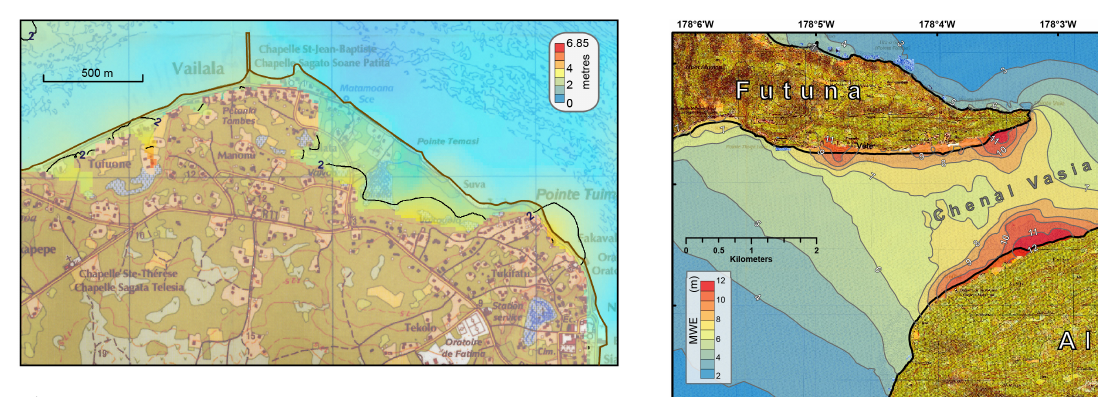
Figure 11. Maximum wave elevation and inundation map at Vailala along the northern coast of Uvéa (Wallis) from an M W = 9.1 Tonga Earthquake. Model generated using the Gerris flow solver. The coastline from the IGN (2007) topo map is drawn in brown.